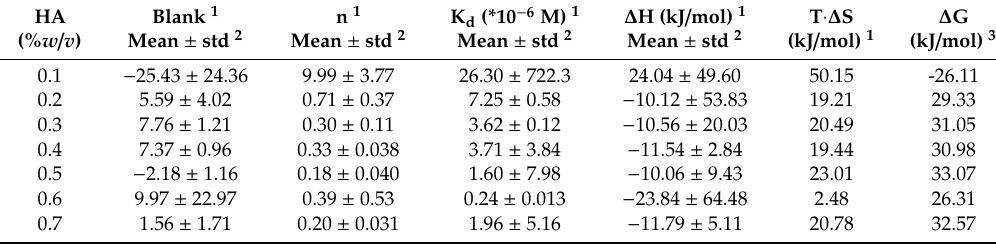
Figure 5. Fitting of ITC data for Gd-DTPA titrated into 0.4% w / v HA. ITC peak area data (empty circles) are plotted as a function of the Gd-DTPA / HA molar ratio. The model curve (solid line) is calculated as the sum of two models: independent sites model plus a constant used for the blank (i.e., Gd-DTPA in water). Residuals of the model and the standard deviation around fit are displayed in the bottom graph. Table 2. Thermodynamic parameters from the modeling of ITC measurements conducted at 25 ◦